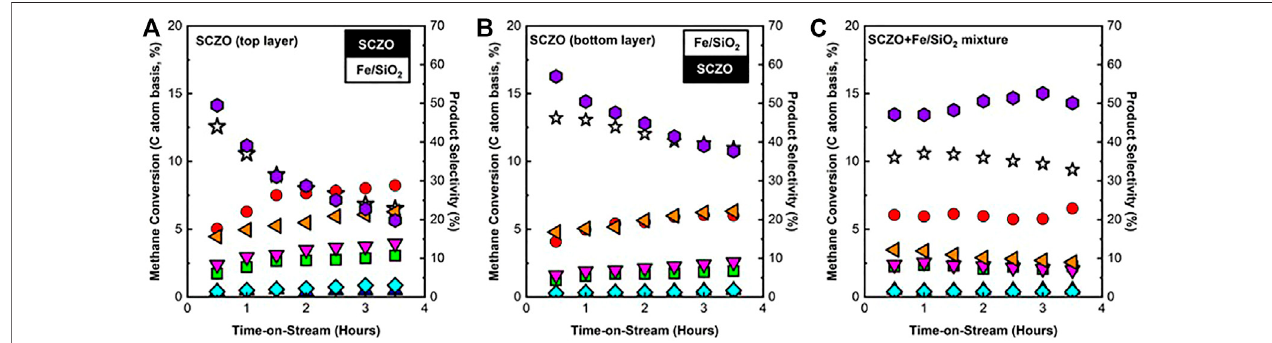
FIGURE4| CH 4 conversion andproductselectivityinDNMCreactionoverFe/SiO 2 catalystandSCZOperovskiteoxidemixturewithdifferentsamplearrangement formatinthereactor: (A) SCZOpacked ontopofFe/SiO 2 , (B) SCZOpacked belowFe/SiO 2 ,and (C) SCZO andFe/SiO 2 wellmixed(massratioofSCZOtoFe/SiO 2 (cid:1)